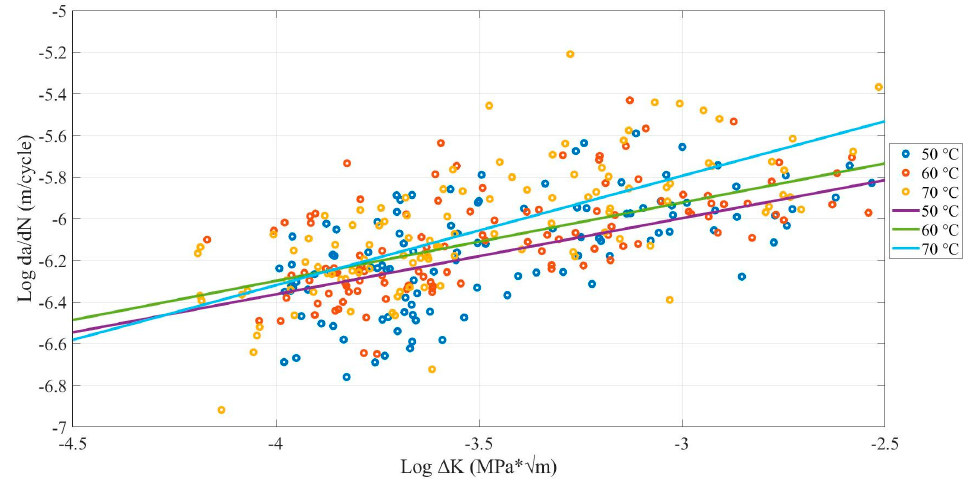
Figure 13. Comparison between the influence of different nozzle sizes of FDM ABS, printed with 0.15-mm layer thickness,